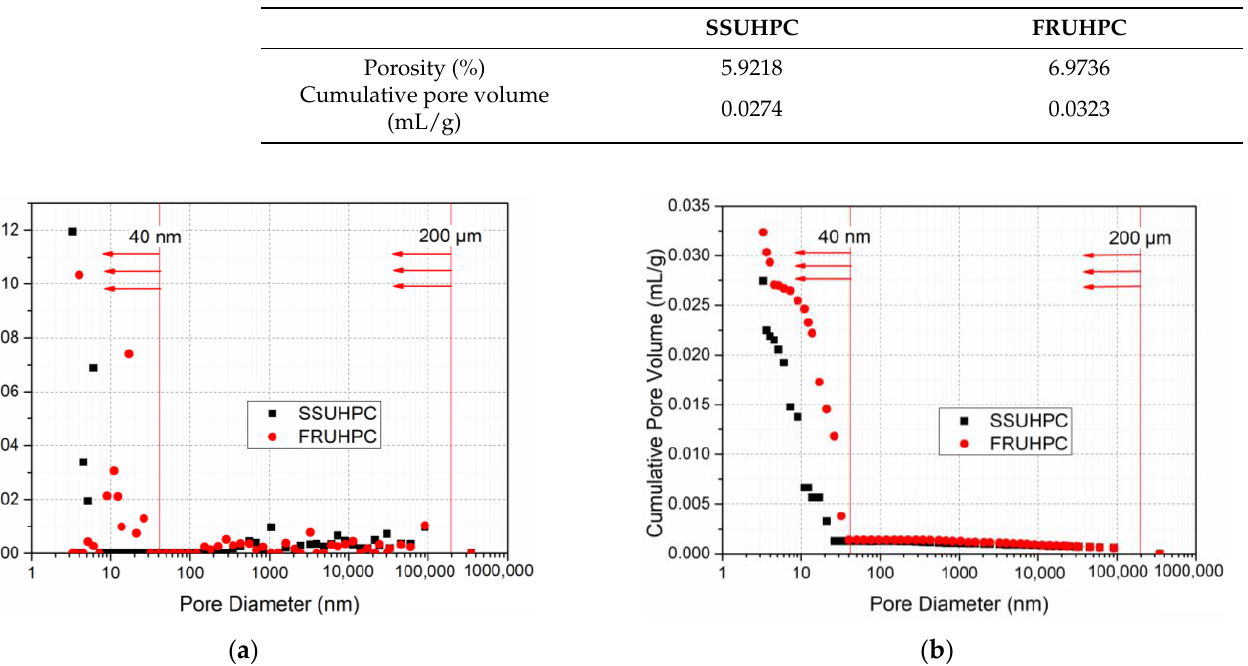
Table 8. Porosity and cumulative pore volume of SSUHPC and FRUHPC obtained by MIP (below 200 µ m).